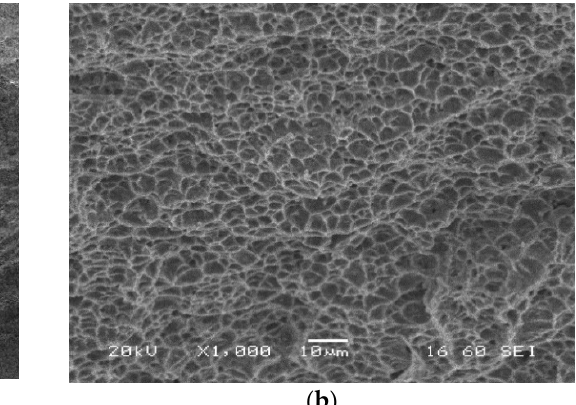
Figure 22. Force versus COD for: the parent material, HAZ and weld.